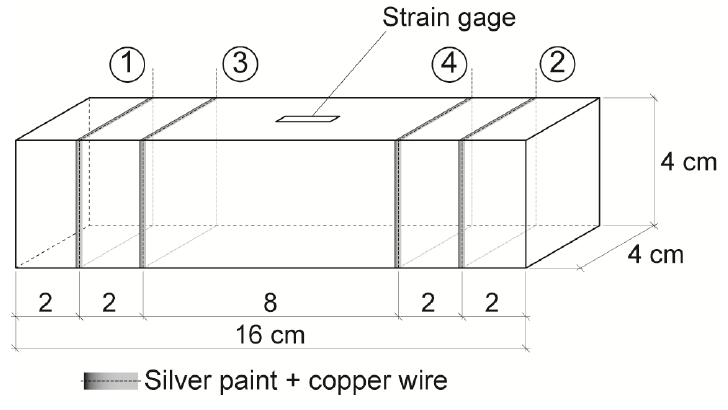
Figure 1. Electrical contacts: 1 and 2 are for current input; 3 and 4 for voltage